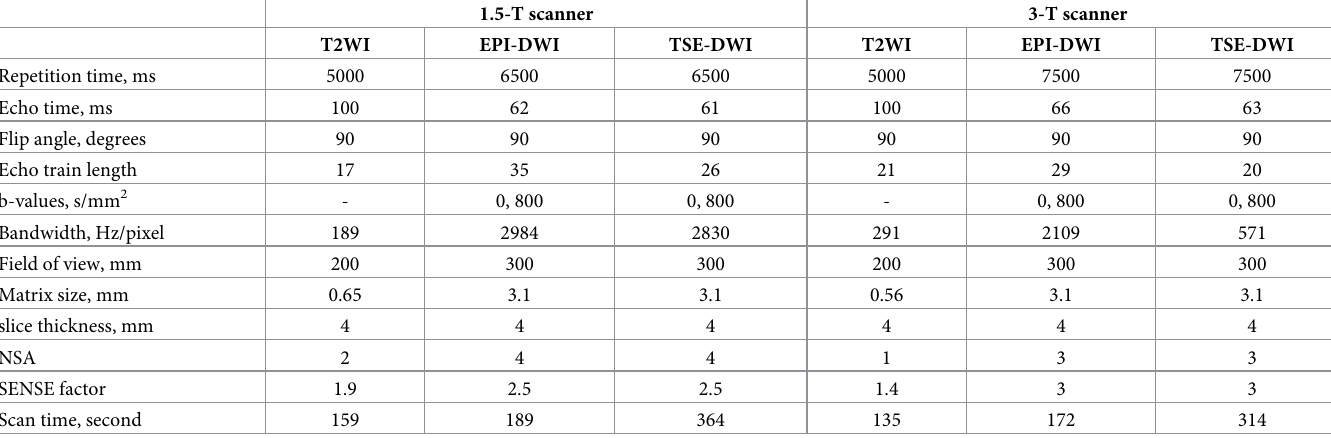
Table 1. Imaging parameters for T2WI, EPI-DWI, and TSE-DWI.